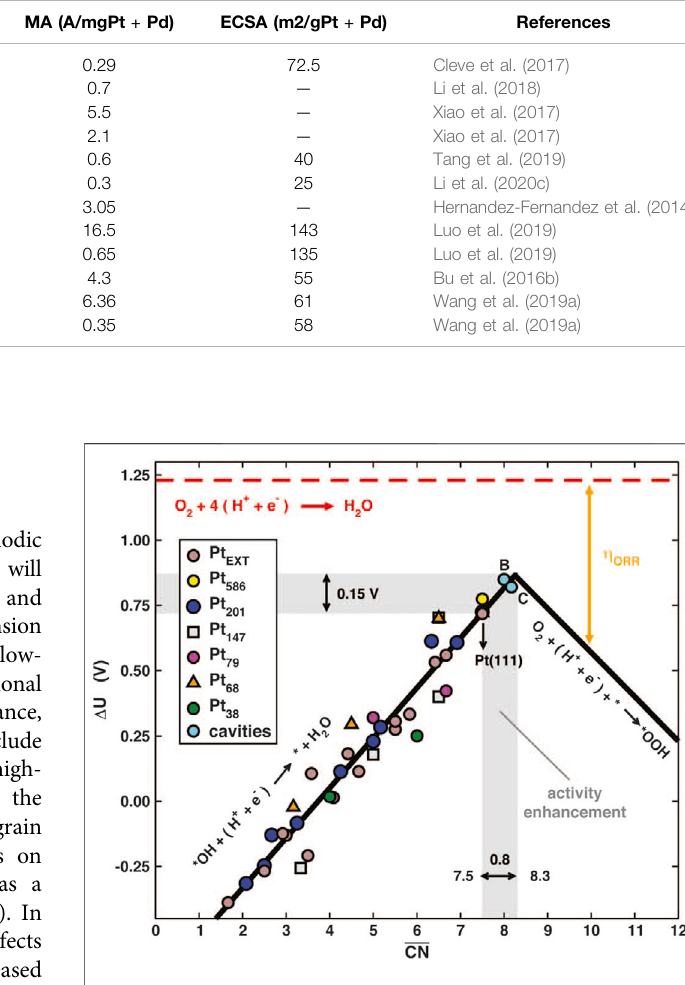
FIGURE 14 | Coordination-activity plot diagram. Potentials for the two limiting steps on extended surfaces and NPs. Reproduced with